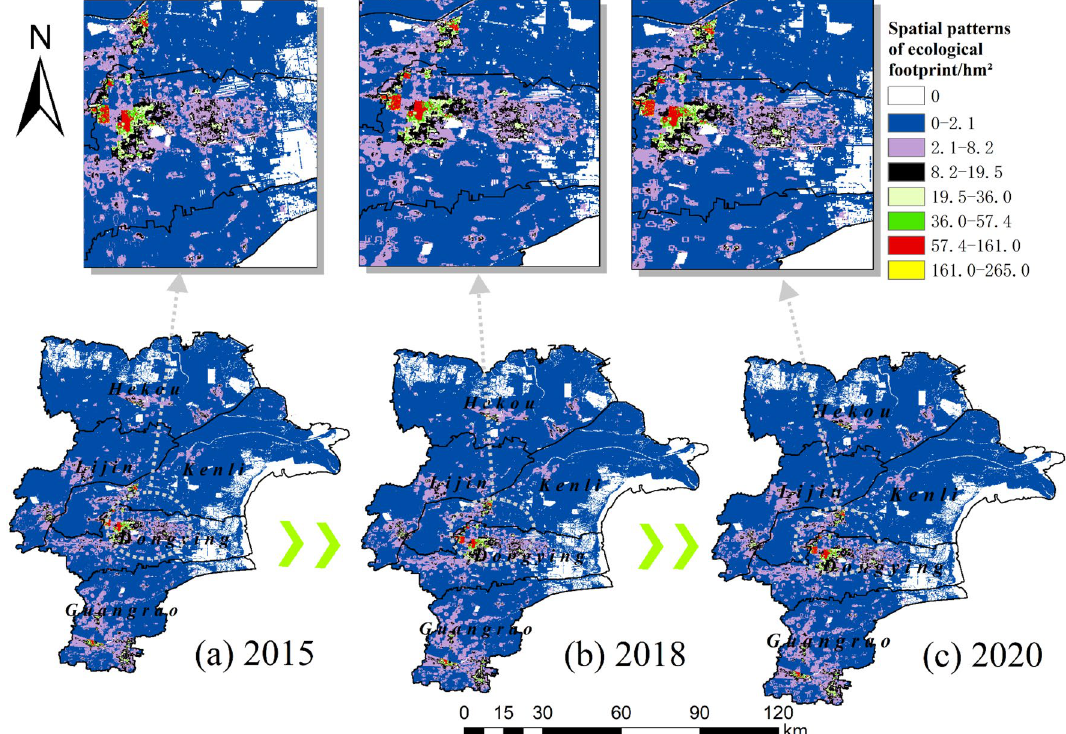
Figure 7. Spatial heterogeneity of ecological footprints in 2015 ( a ), 2018 ( b ) and 2020 ( c ). This figure was created with ArcGIS 10.2 (https:// suppo rt. esri. com/ en/ downl oad/